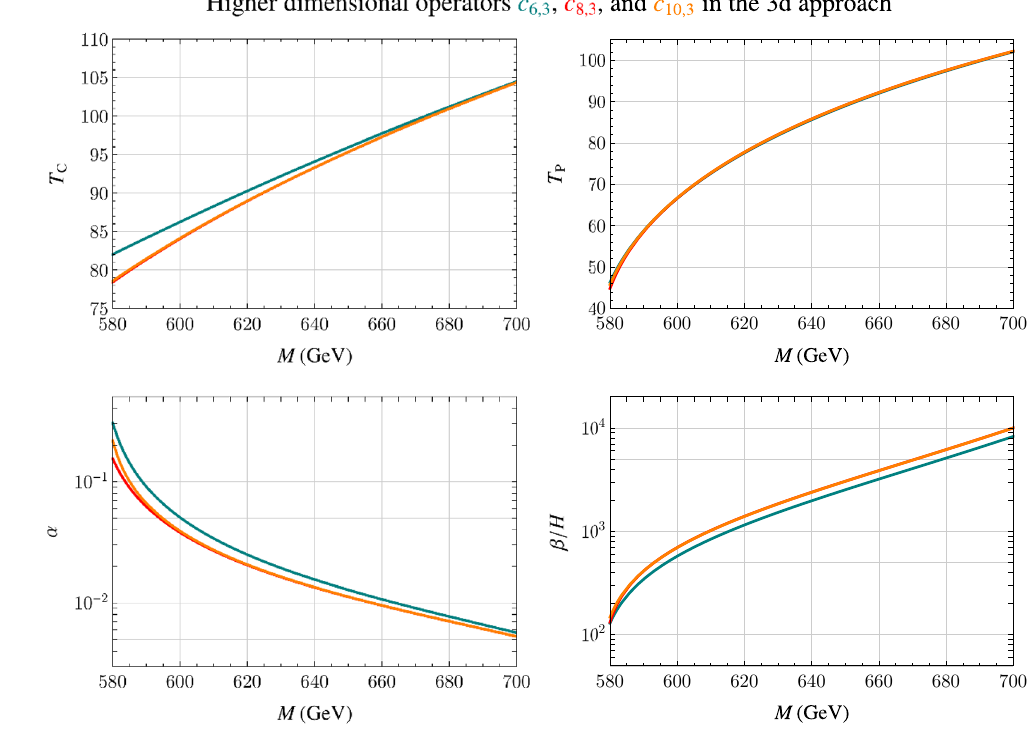
Figure 6 . Estimate of the uncertainty in our 3d approach due to truncating the effective theory at ( φ † φ ) 3 . The cyan lines are the LO results in this truncation, the red lines include also the ( φ † φ ) 4 operator and the orange lines include both the ( φ † φ ) 4 and ( φ † φ ) 5